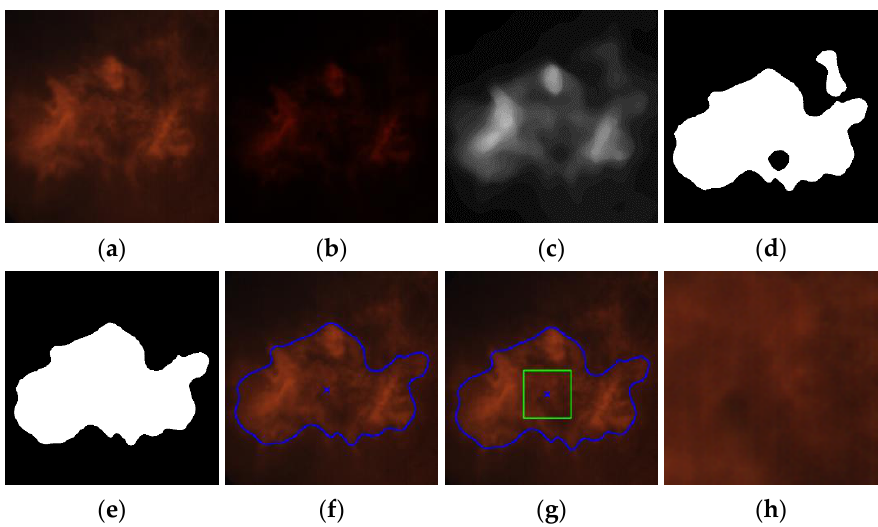
Figure 7. Results of the most important operations performed during image processing: ( a ) source image; ( b ) the result of the gamma correction according to the function G = f(meanR) (Figure 4); ( c ) greyscale image after histogram normalization and median filtering; ( d ) binary image after thresholding with the Otsu method; ( e ) image after morphological operations (closing, opening) and finding the contour with the largest area; ( f ) the image with the contour of the flame marked and its centroid (blue cross); ( g ) image with the ROI marked (green square of a size of 100 × 100 or 40 × 40 pixels), the center of which is in the contour’s centroid; ( h ) the ROI copied from the source image (without gamma correction). For greater readability, the above images show the central part of the images processed that include the flame. The sizes of all images (except the ROI) were 800 × 800 pixels.